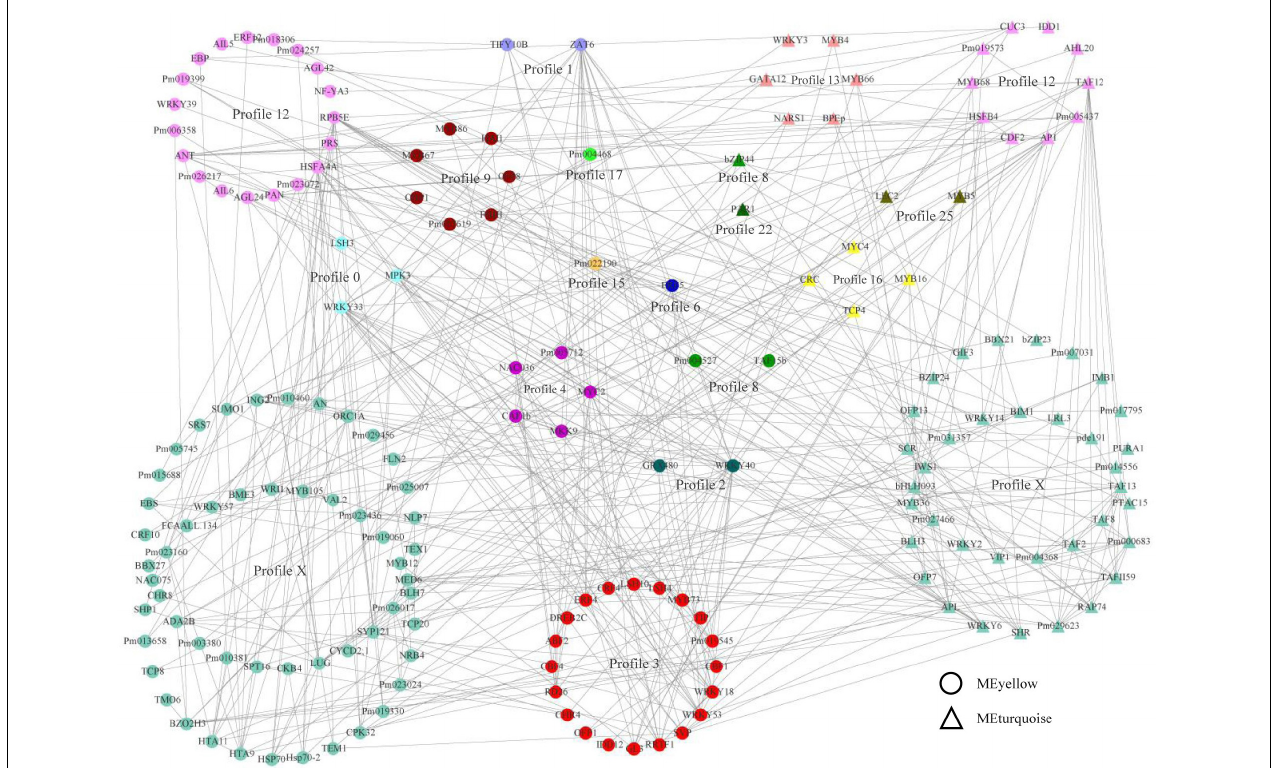
FIGURE 4 | A network of expression and transcriptional regulation. The transcription factors in the turquoise module were noted with triangles, and those in the yellow module were noted with circles. The colors indicated the trends in which the genes were